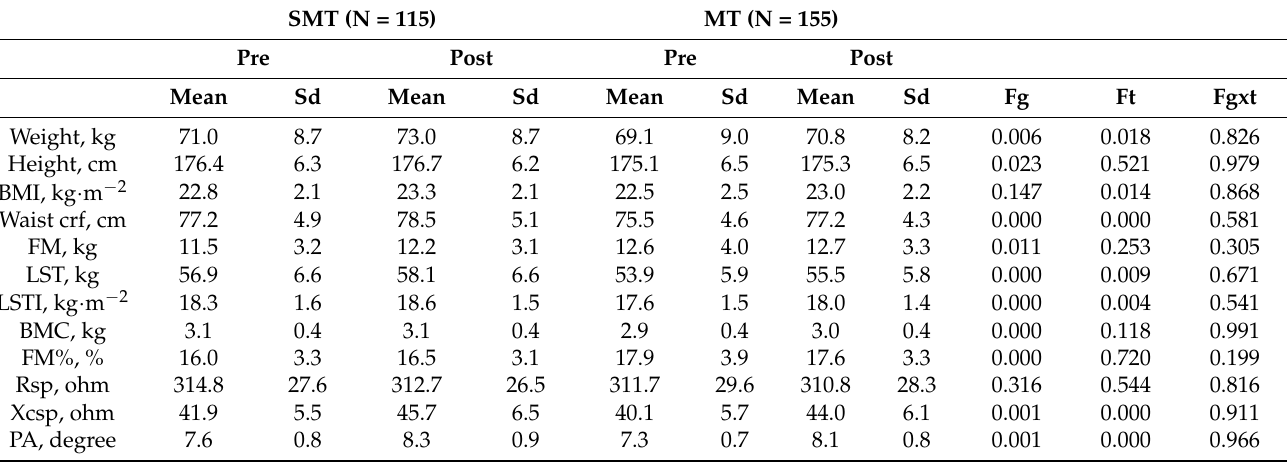
Table 3. Descriptive and comparative statistics.